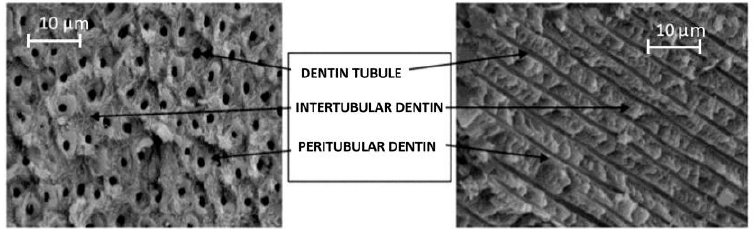
Figure 4. Dentinal tubules observed on the surface and in cross section.